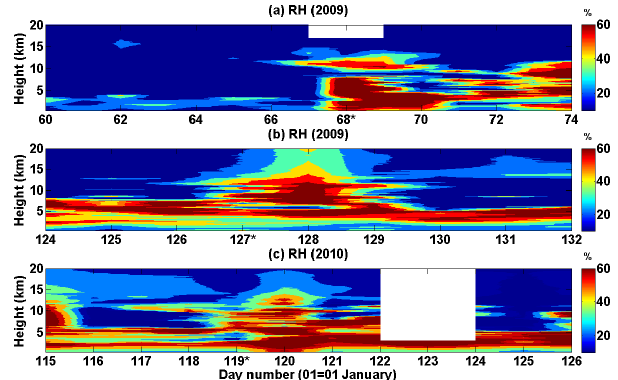
Figure 5. Time-height variation of RH obtained from the ra- diosonde measurements at Gadanki station (13.5 ◦ N, 79.2 ◦ E) for the 2009 and 2010